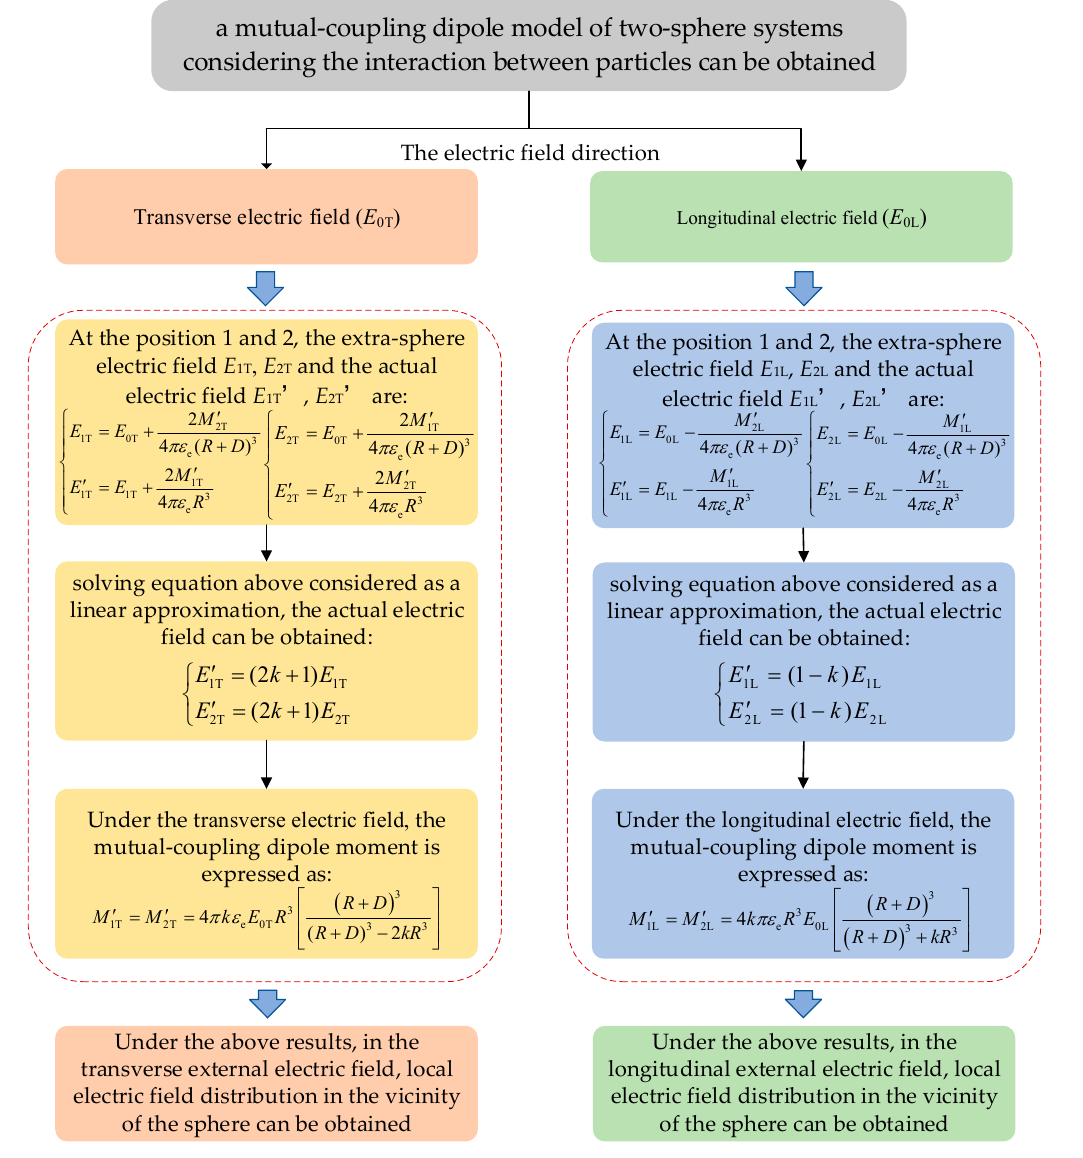
Figure 4. The mutual-coupling dipole model for calculating the equations under different scenar ‐ ios.